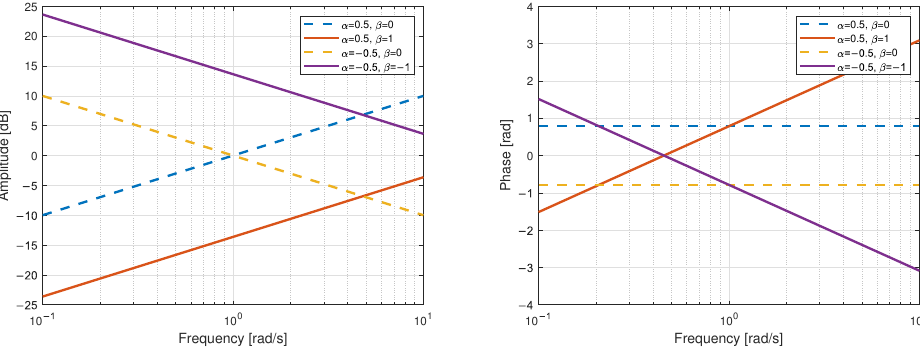
Figure 1. Amplitude ( left ) and phase ( right ) characteristics of the complex-order differintegral s α + j β